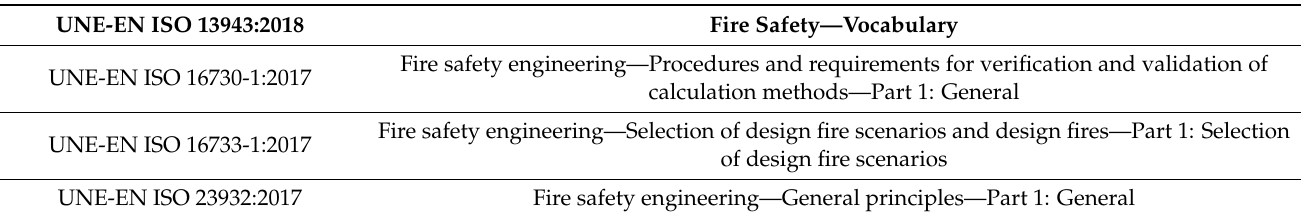
Table 9. List of the standards for the development of performance based design proposed by the Basic Document DB SI, Annex G. Adapted by the